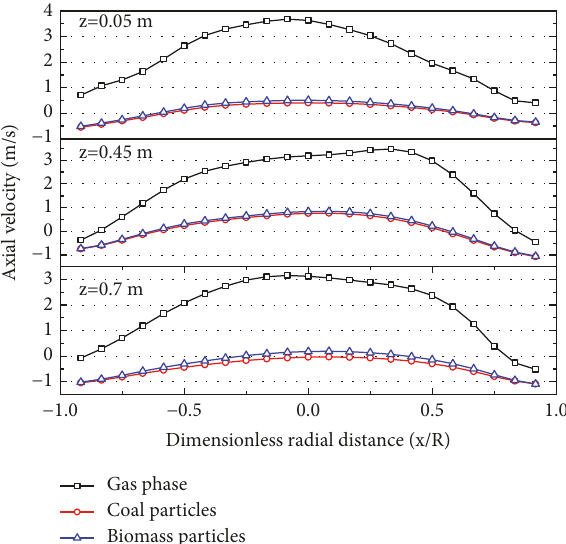
Figure 6: The axial velocity profile of coal, biomass, and gas phase